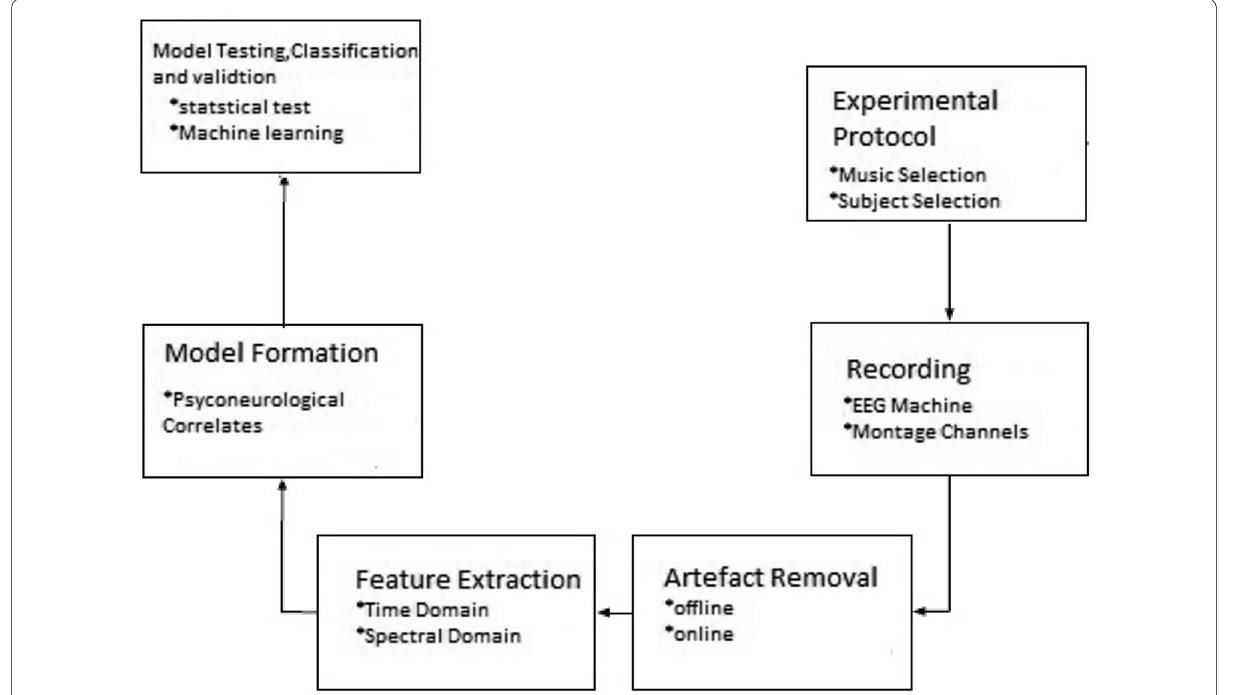
Fig. 2 Experimental approach adopted in